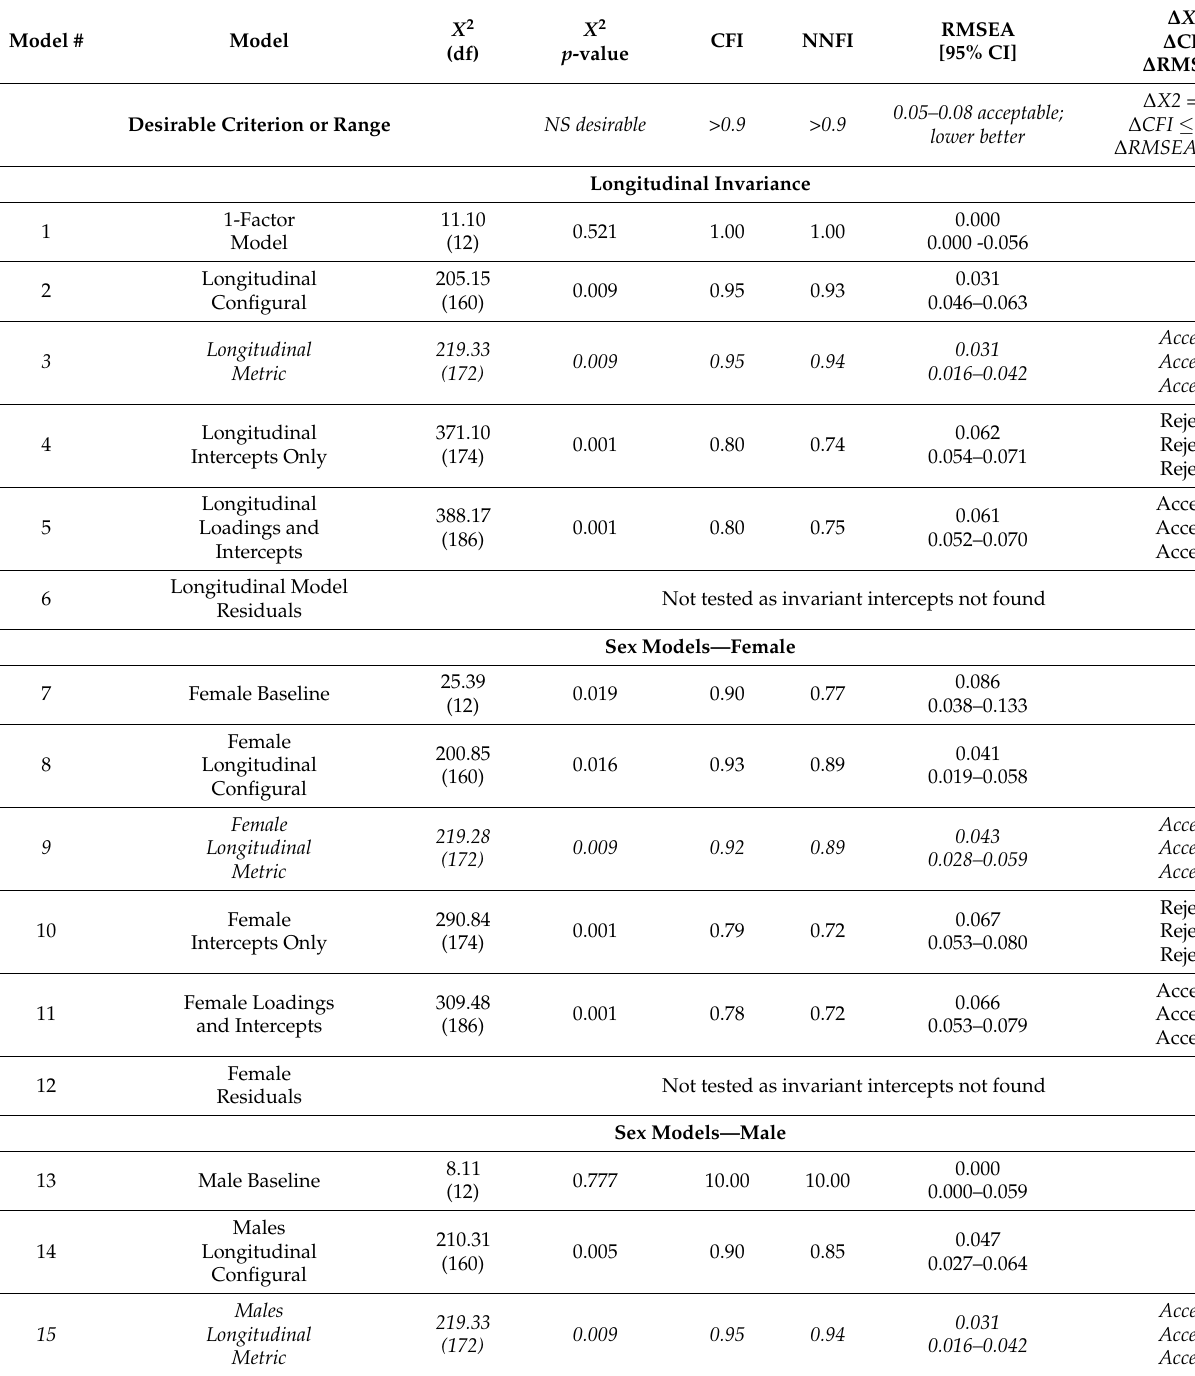
Table 2. Model Comparison for Reduced (7-Item) HEI-C